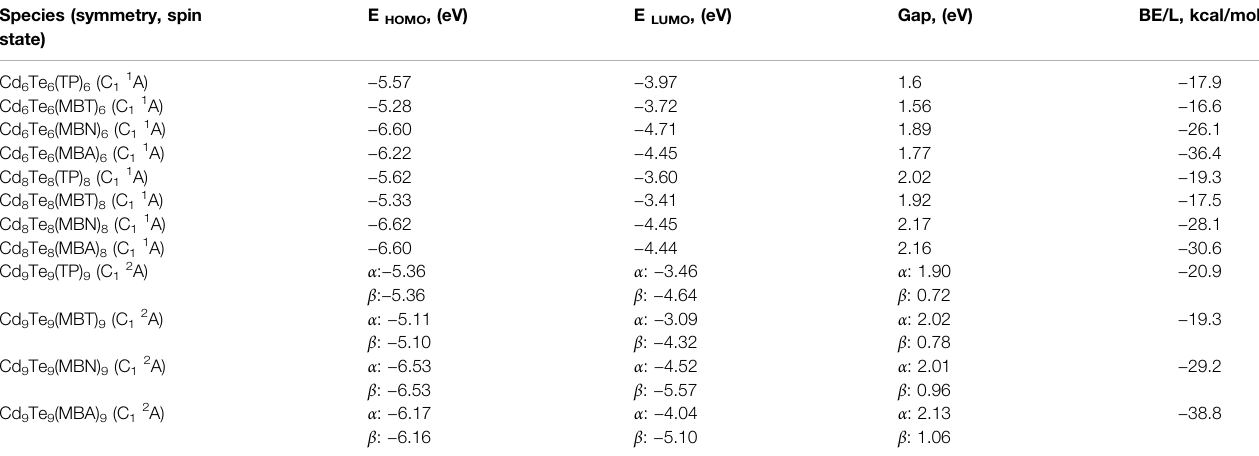
TABLE 5 | E HOMO and E LUMO energies (eV), HOMO-LUMO gaps (eV), and binding energy (BE/L) in kcal/mol of capped Cd n Te n L n ( n (cid:1) 6, 8, and 9) QDs (where L (cid:1) TP, MBT, MBN, and MBA) calculated with B3LYP/Lanl2dz approach. Species (symmetry, spin